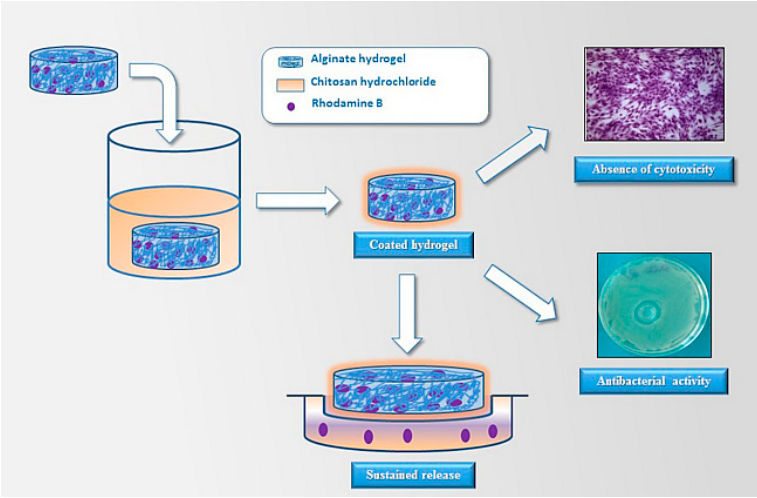
Figure 2. Preparation of alginate hydrogels coated with chitosan for wound dressing. (Reprinted from reference [20]).